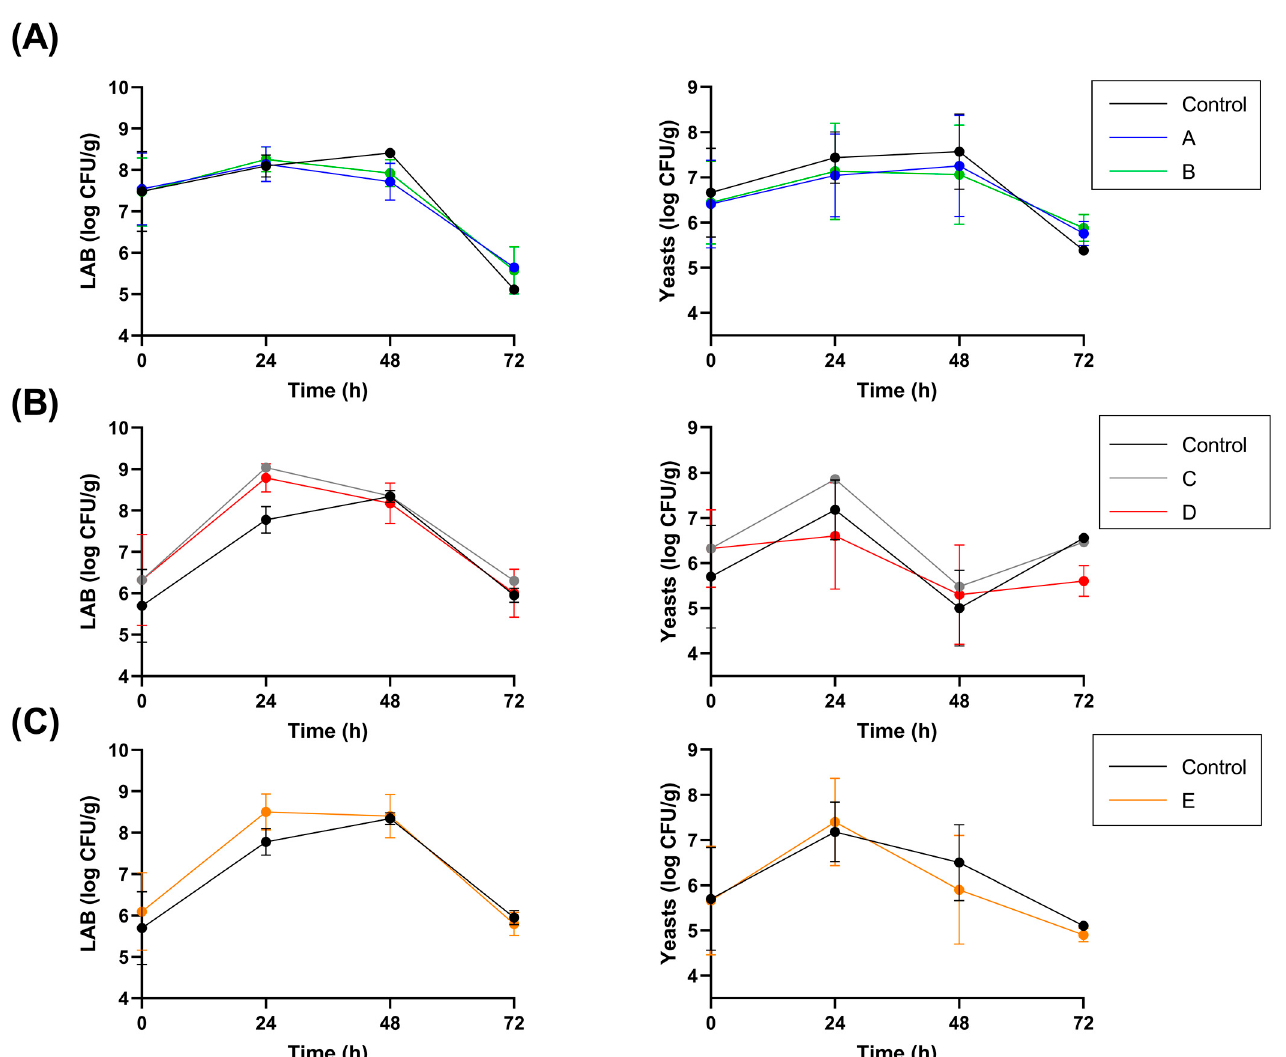
Figure 1. LAB and yeast counts for each inoculated species and different inoculation protocol, in comparison with spontaneous fermentation (black): ( A ) L. fabifermentans at t 0 (blue) and t 0 + t 48 (green), ( B ) F. rossiae at t 0 (grey) and t 0 + t 48 (red), ( C ) co-culture at t 0 + t 48 (orange).